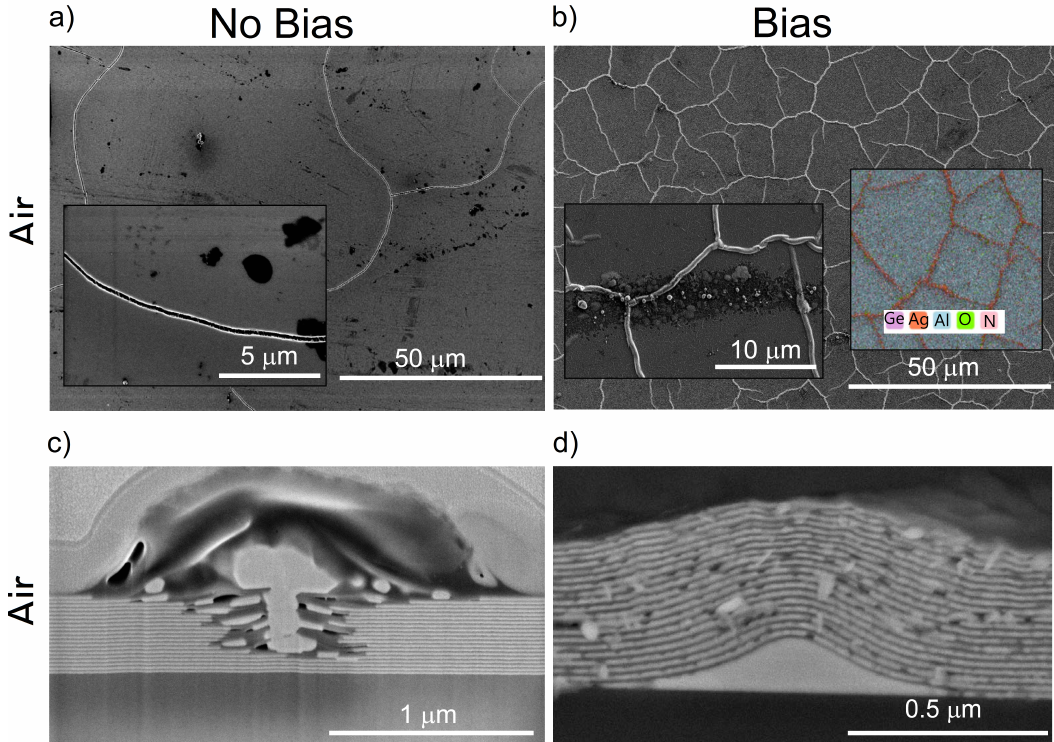
Figure 5. SEM planar images of samples annealed at 400 ◦ C in air ( a ) without bias and ( b ) with bias; ( c ) cross section SEM of ( a ) through a crack with Ag outflow; ( d ) SEM cross section of ( b ) through a wrinkle. The inset in ( b ) is the elemental EDX